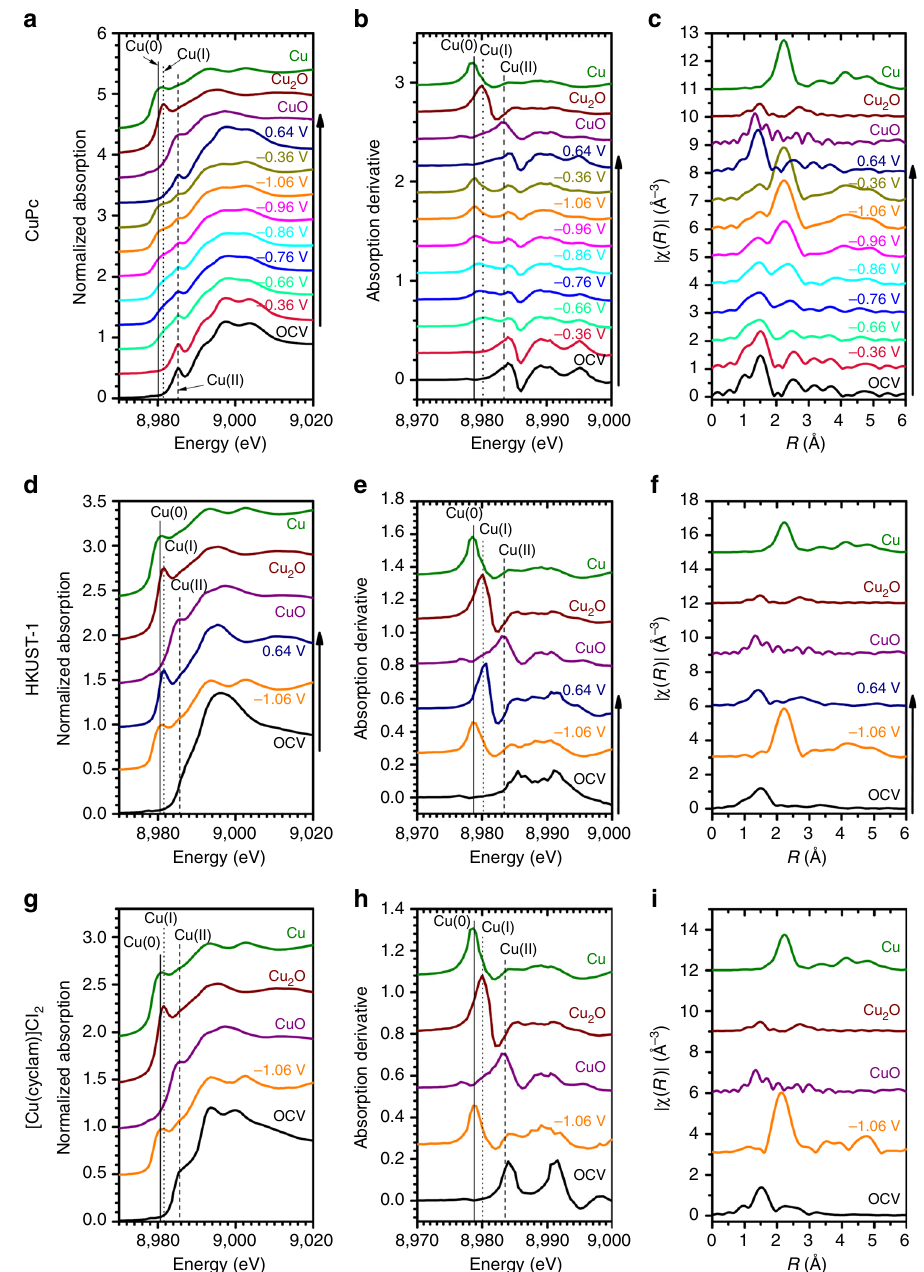
Fig. 2 In situ XAS measurements under electrocatalytic reaction conditions. a Cu K-edge XANES spectra, b fi rst-order derivatives of the XANES spectra, and c Fourier-transformed Cu K-edge EXAFS spectra for CuPc. Similarly, the corresponding XAS spectra for HKUST-1 are plotted in d – f and for [Cu (cyclam)]Cl 2 in g – i . The slight off-alignment of the Cu(II) peaks in the XANES derivatives b , e , h with that of CuO is mainly due to the different local geometries of the Cu complexes and